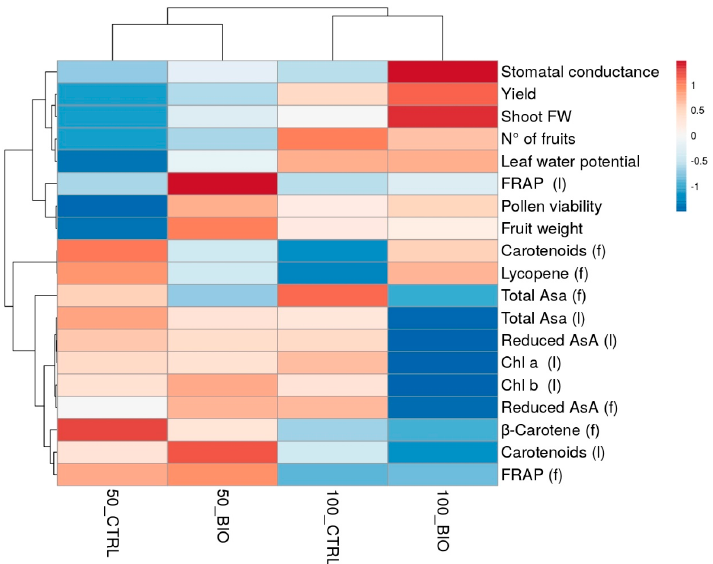
Figure 5. Heat map analysis summarizing plant responses to biostimulant application and wa- ter deficit in plants grown in Battipaglia under optimal (100) and limited water availability (50) and treated (BIO) or not (CTRL) with the protein hydrolysate. The letters in brackets in- dicate measurements taken from leaves (l) and fruits (f). The Figure was generated using the http://biit.cs.ut.ee/clustvis (accessed on 1 April 2021) program package with Euclidean distance as the similarity measure and hierarchical clustering with complete